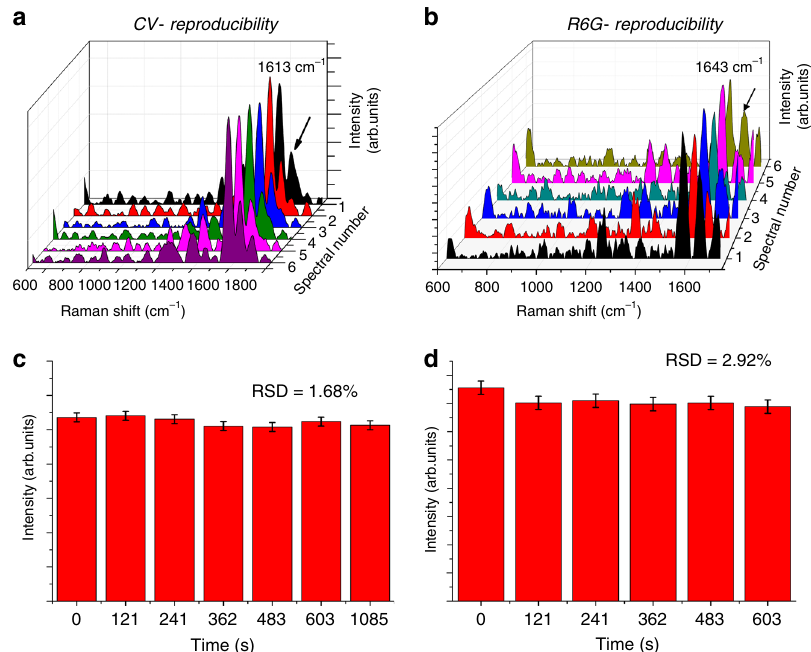
Fig. 3 Reproducibility of SERS signals by QOS. Reproducibility analysis of SERS signals of a , b CV, R6G on QOS, respectively, on QOS, c intensities of characteristic CV peak at 1613cm − 1 shown in spectra a error bars: SD, d intensities of characteristic R6G peak at 1643cm − 1 shown in spectra b error bars: